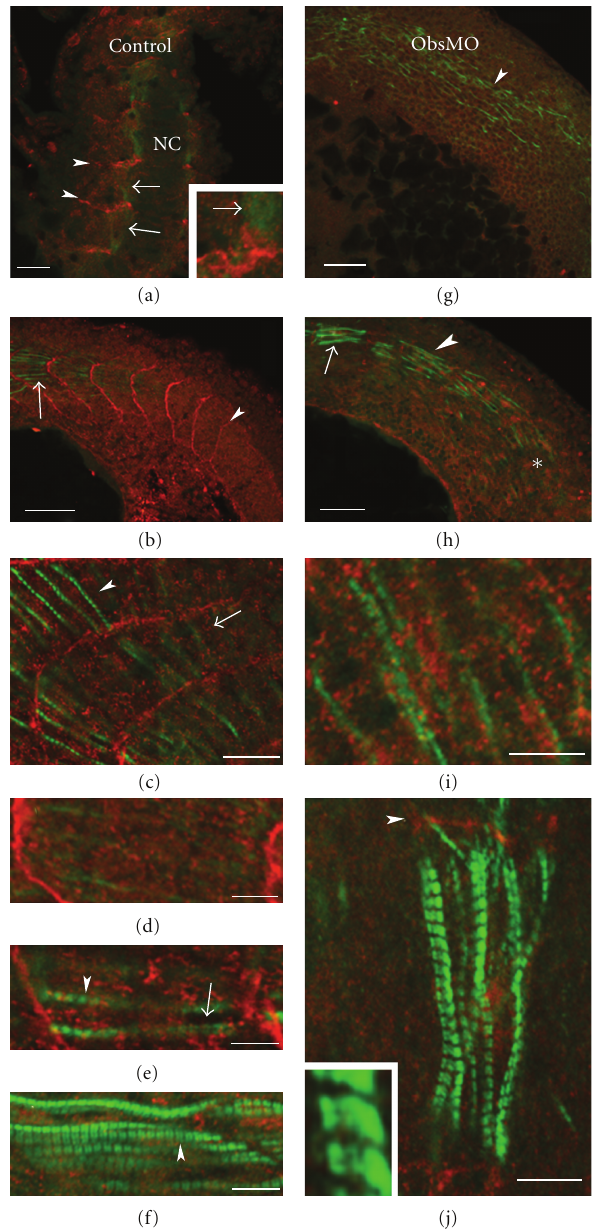
Figure 4: Organization of the fibronectin matrix precedes new myofibril assembly. Zebrafish embryos at 14 (a), 20 (b)–(e), (g), 24 (f), (h)– (j) hpf were immunolabeled for fibronectin (red) and slow-twitch myosin heavy chain (F59 antibody) (green). (a) Fibronectin organizes next to the notochord (NC) at nascent somite boundaries (arrowheads). Myosin heavy chain is still di ff usely localized (arrows: (a) and inset) as the fibronectin matrix is organizing. (b) In a control embryo, the fibronectin matrix (arrowhead) is organized at the somite boundary before assembly of mature myofibrils in slow-twitch skeletal muscle of the younger somites at the right of the panel. (c) At higher magnification, continuous bands of myosin staining (arrow) are noted extending between the organized fibronectin matrix at either end of the myocytes before organizing into a striated pattern (arrowhead). (d)–(f) As development proceeds, MHC localization transitions from a di ff use distribution (arrows) along new myofibrils to a distinct restriction to the A band (arrowheads) and finally to a mature “double- banded” pattern ((f): arrowhead) with central clearing in the region of the future M band. By comparison, obscurin A depletion (g)–(j) a ff ects fibronectin matrix organization and results in reduced organization of the MHC filaments. (g)–(j) Myofibril maturation can progress from immature myofibrils ((g), (h): arrowheads) to mature myofibrils ((h): arrow) even with a reduced and poorly organized fibronectin matrix (i). However, myofibrillogenesis proceeds more rapidly in regions with preserved fibronectin deposition ((j): arrowhead). Note the fibronectin organization at the terminal ends of the myofibrils (j). Lateral bundling of myofibrils appeared to be delayed in response to obscurin depletion as noted by the gaps between the A bands of neighboring but not yet fused myofibrils (inset of (j)). Scale bars are 50 μ m (b), (h), 20 μ m (a), and 10 μ m (c), (d), (e), (f), (i), (j). Insets in (a) and (j) are 3x magnification of the larger